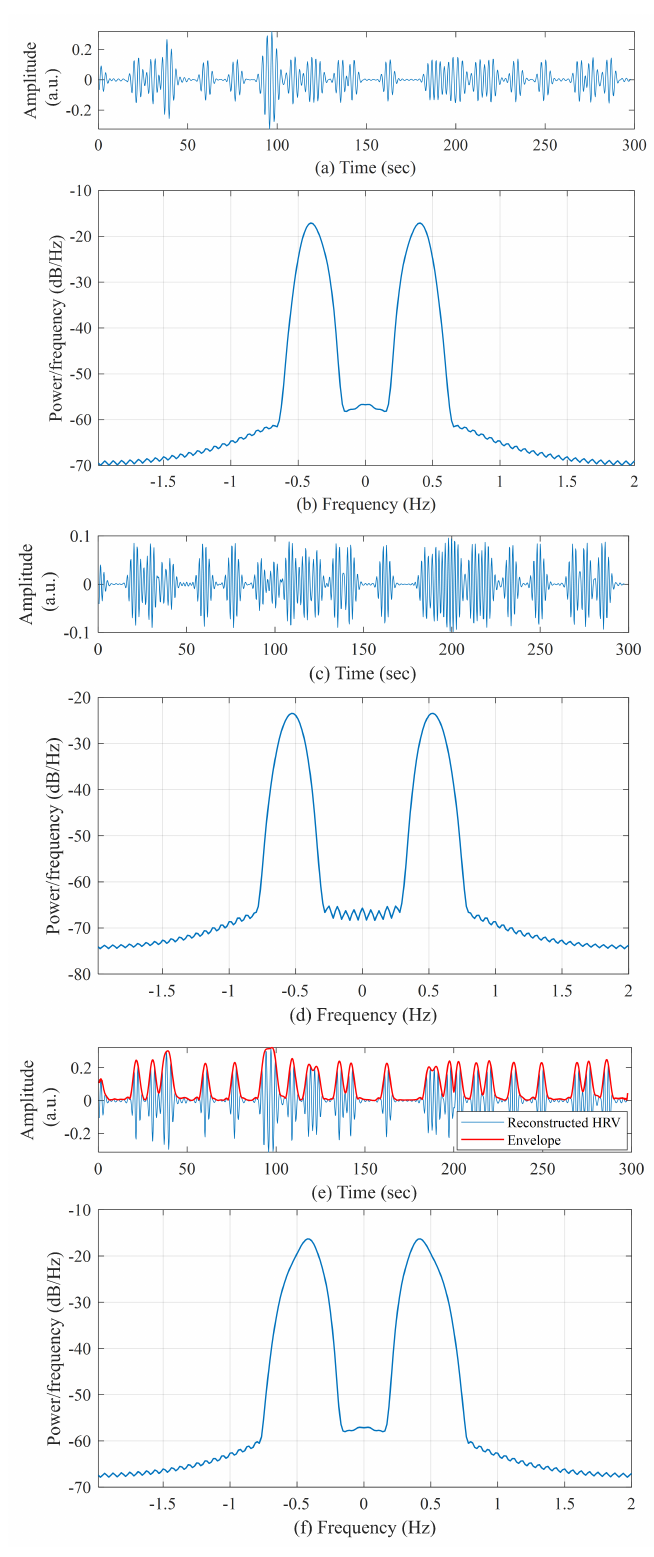
Figure 5. For a sample 5-min pre-AF heart rate signal: ( a ) third component of the VFCDM decomposi- tion; ( b ) PSD of the third component; ( c ) fourth component of the VFCDM decomposition; ( d ) PSD of the fourth component; ( e ) reconstructed heart rate signal along with the Hilbert transform envelope; and ( f ) PSD of the reconstructed heart